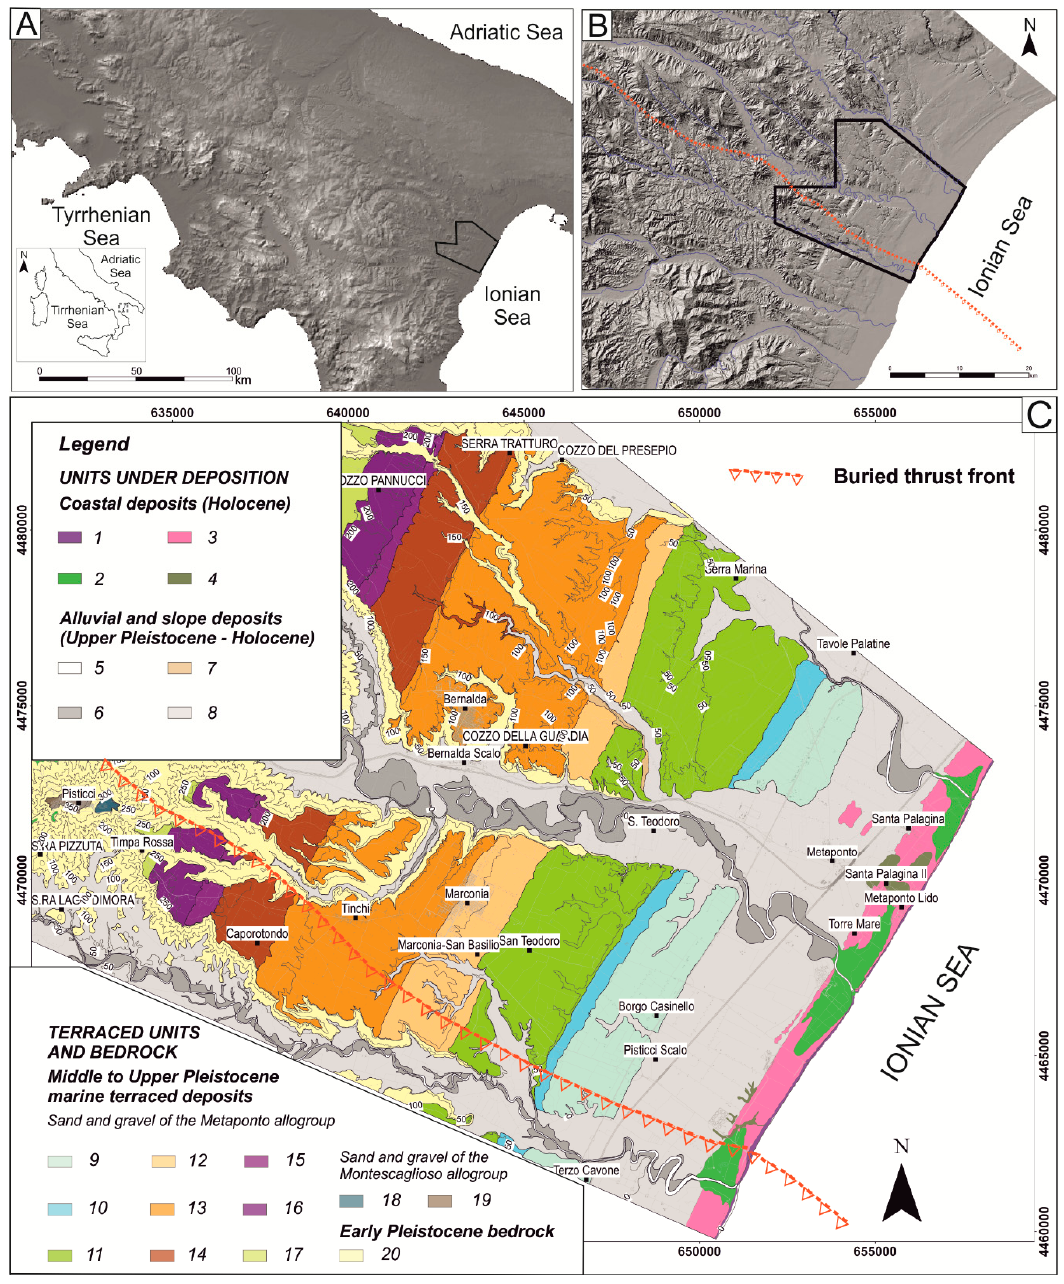
Figure 1. Location of the study area ( B ) within of the regional framework of the southern Italy ( A ); ( C ) lithological map of the study area. (1) Present-day beach/dune deposits; (2) Present-day and relict deltaic deposits (Holocene); (3) Relict dune deposits (Holocene); (4) Palustrine/lacustrine backshore deposits (Late Pleistocene-Holocene); (5) Present-day alluvial deposits; (6) Alluvial deposits (Holocene); (7) Slope deposits (Holocene); (8) Terraced alluvial deposits and coastal plain deposits (Late Pleistocene-Holocene); (9) Scanzano alloformation, Upper Pleistocene; (10) San